Question: Summarize what this figure shows in one sentence.
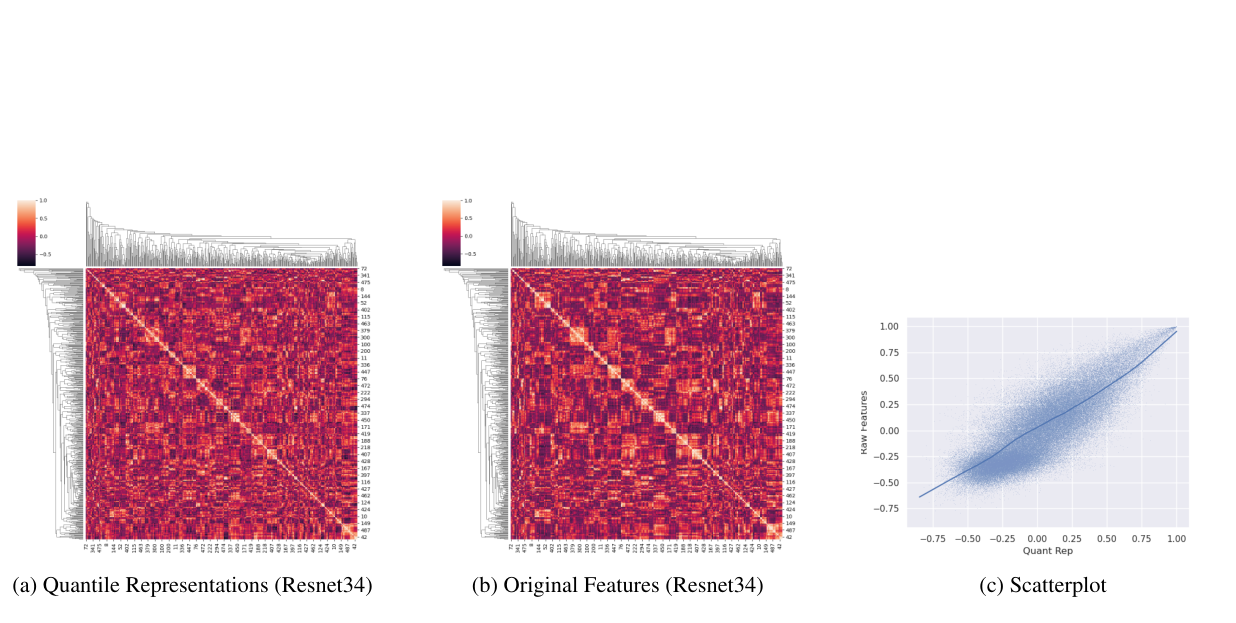
Answer: Do quantile representations capture the relevant information for classification? (a) Cross-correlations obtained using Quantile representations for Resnet34 on CIFAR10 (b) Cross-correlations obtained using train features for Resnet34 on CIFAR10. (c) Scatterplot with best fit line (using Locally Weighted Scatterplot Smoothing[Cleveland, 1979]) of the cross-correlation of features. Observe that as the correlation becomes important (i.e close to −1 or 1) quantile representations are more consistent with raw features.